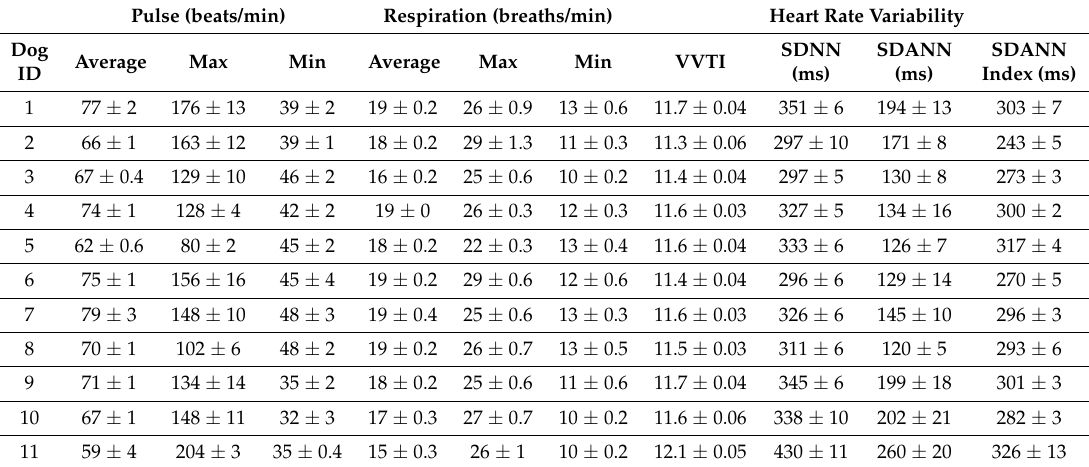
Table 3. Mean, maximum and minimum ± SE 24-h pulse and respiration, and mean ± SE HRV time-domain